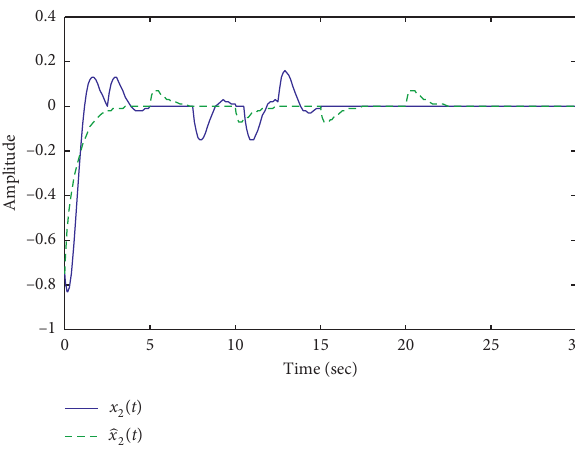
Figure 3: Response of state x